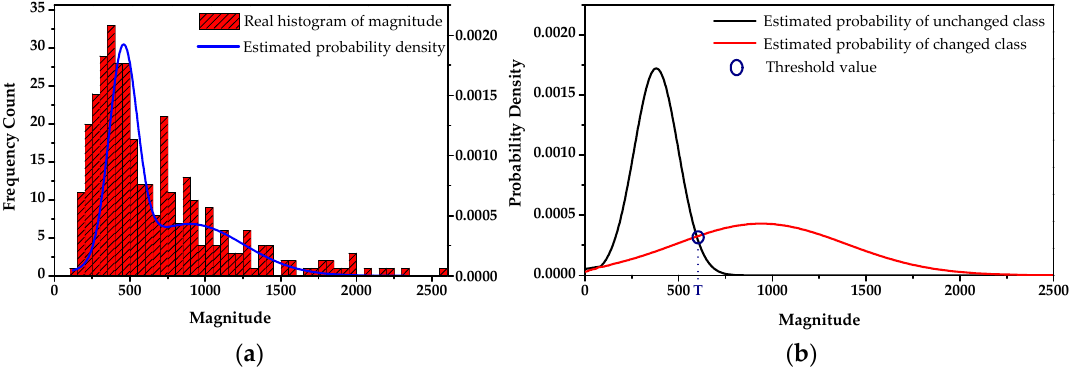
Figure 4. ( a ) The real histogram of magnitude (red bars) and estimated probability density curve (blue line) by the EM algorithm under Gaussian assumption; ( b ) The curves of estimated probability of unchanged (black line) and changed (red line) classes, and the estimated threshold value (blue point) to separate these two classes.